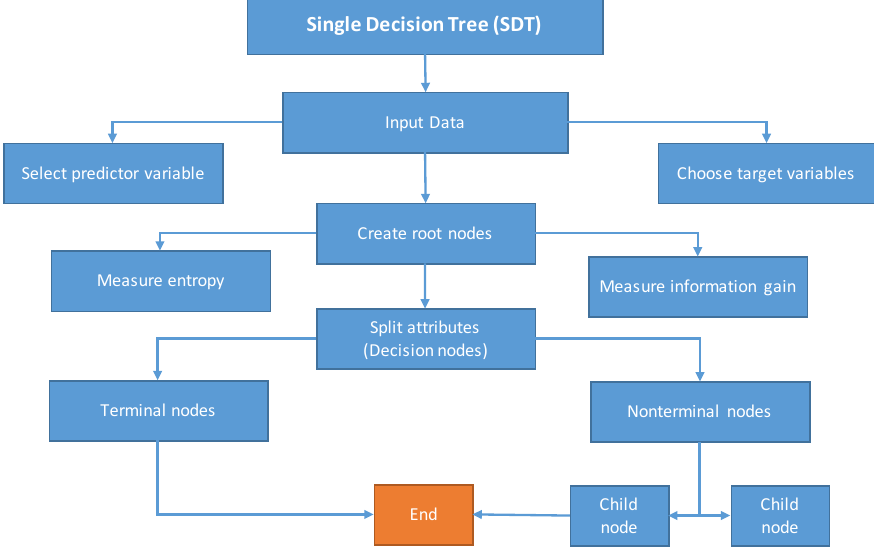
Figure 3. Single decision tree (SDT) flow chart (reproduced from Raza et al. [37]).